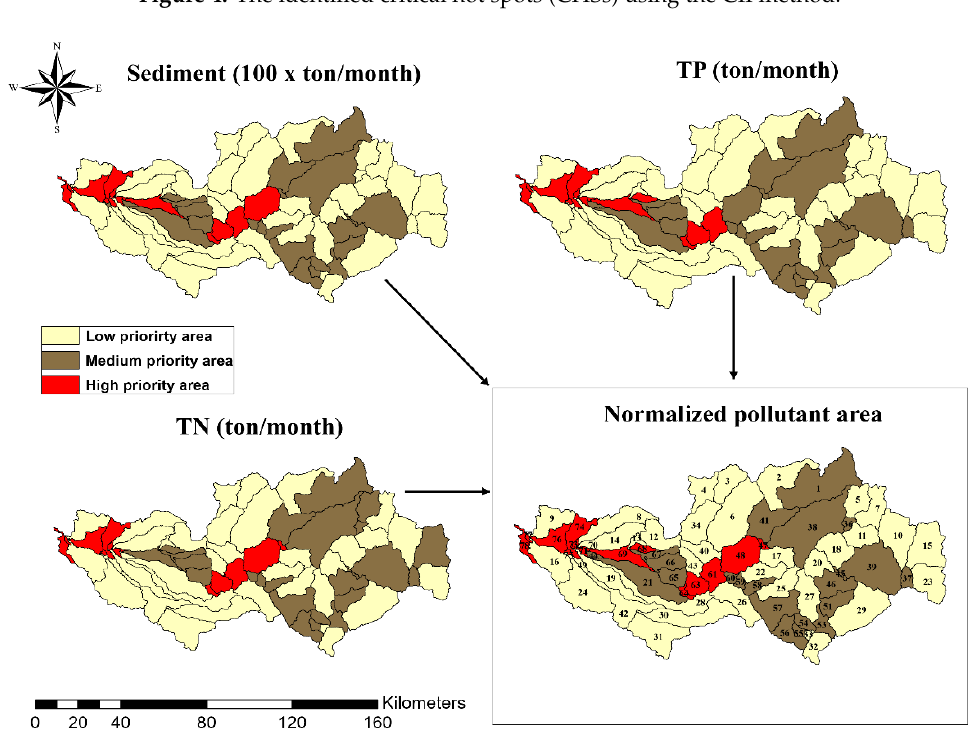
Figure 5. The identified critical hot spots (CHSs) using the LII method.